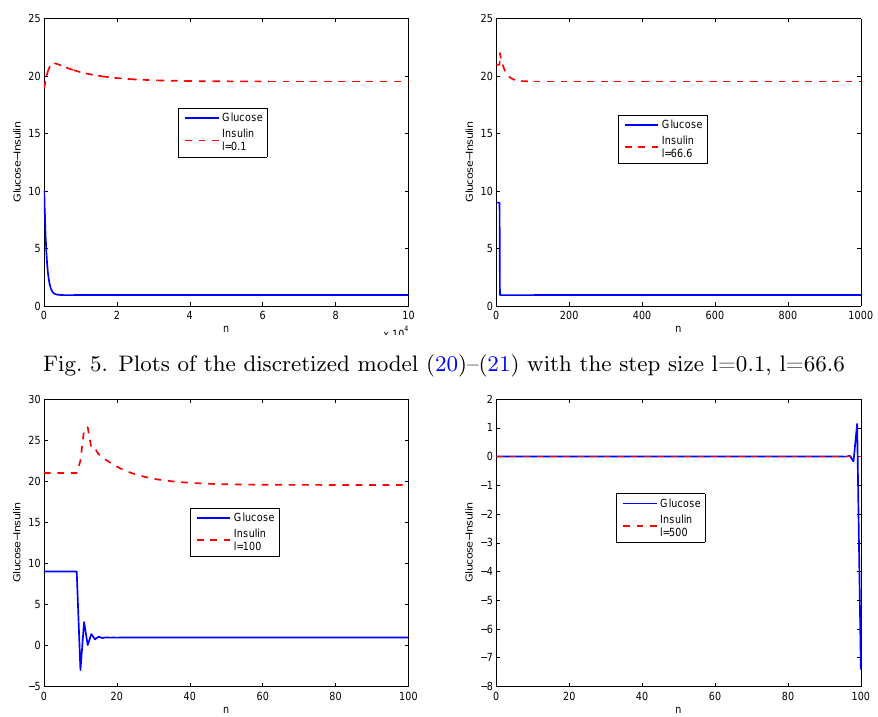
Fig. 5. Plots of the discretized model (20)–(21) with the step size l=0.1, l=66.6